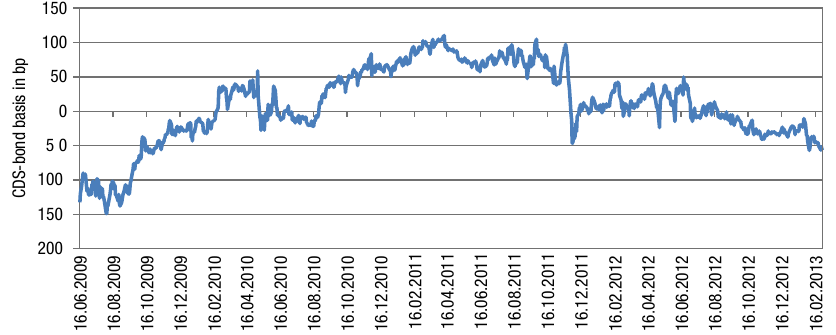
Fig. 4. CDS-bond basis in basis points from 15 June 2009 to 1 March